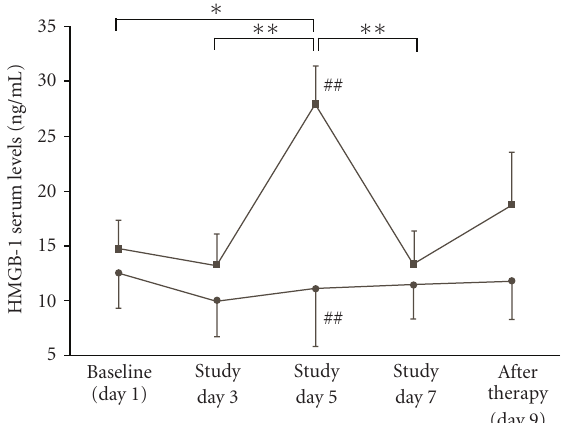
Figure 1: Course of HMGB-1 serum levels (ng/mL) from baseline until study day 9 (after immunotherapy) for GM-CSF (squares) and placebo-treated (circles) individuals. ∗ P ≤ . 05, ∗∗ P ≤ . 01 (GM- CSF-treated individuals); ## P ≤ . 01 between the two groups at the same day of assessment. Means ± SEM are given, paired and unpaired samples t -test, as